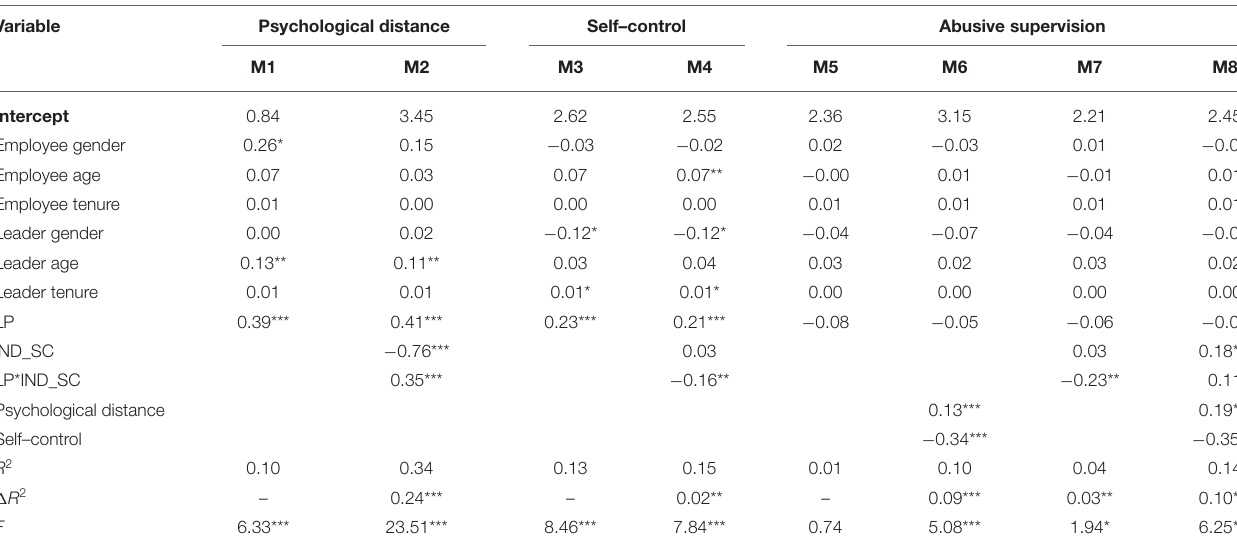
TABLE 2 | Regression results of Study 1.